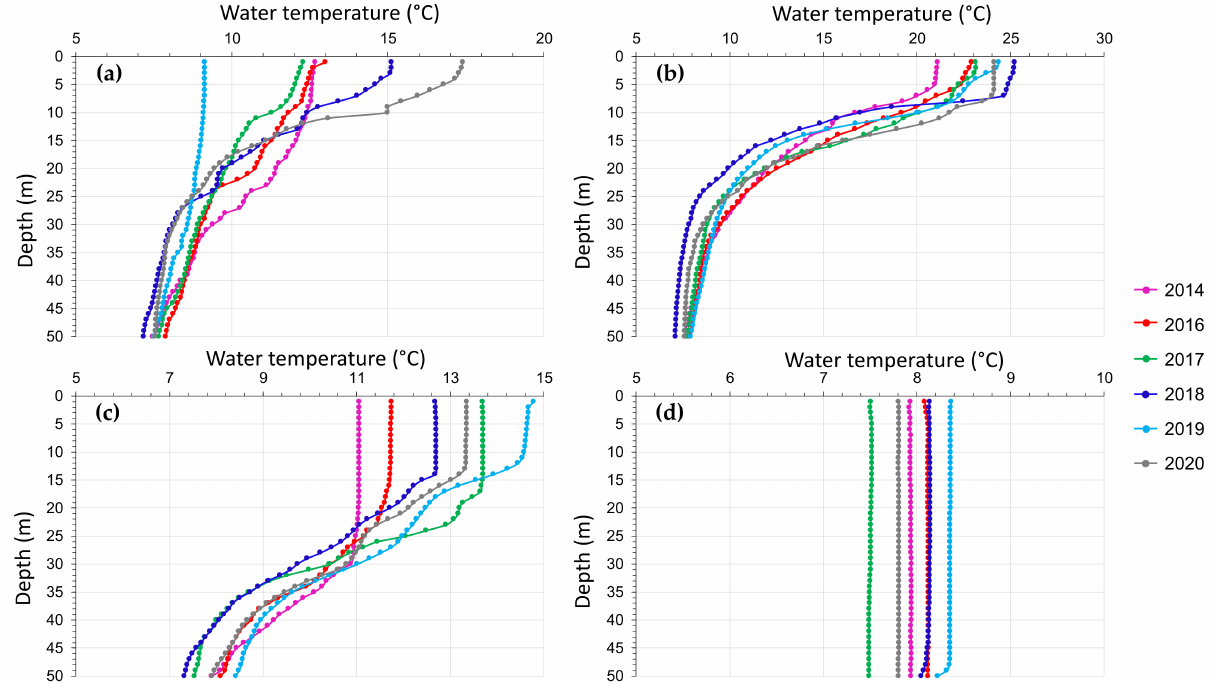
Figure 5. Vertical profiles of water temperature of the upper 50 m in Lake Maggiore during different seasons of the investigated years (2014 and 2016–2020): ( a ) spring; ( b ) summer; ( c ) autumn; ( d ) winter. The total zooplankton biomass in Lake Maggiore (of the ≥ 450 µ m size fraction) ranged between 3 and 33 µ g L − 1 , with a mean of 13 µ g L − 1 . These values are in line with the most oligotrophic sectors of Lake Champlain (USA), which showed biomass comprised between about 9 and 21 µ g L − 1